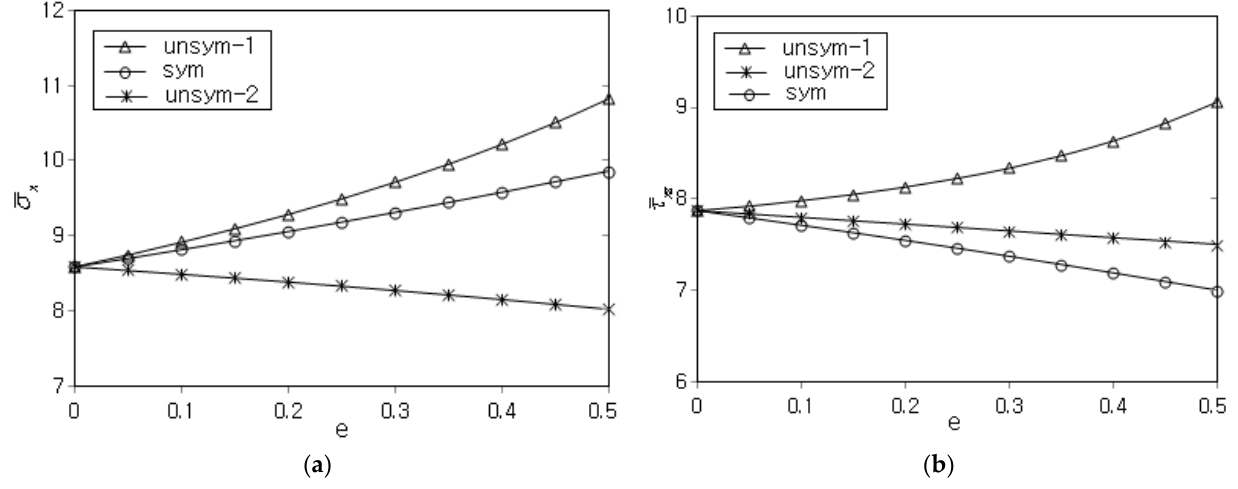
Figure 6. Dependence of the calibrated stress on the porosity parameter ( a / h = 20, n = 0.3 ) : ( a ) axial stress σ x , ( b ) shear stress τ xz